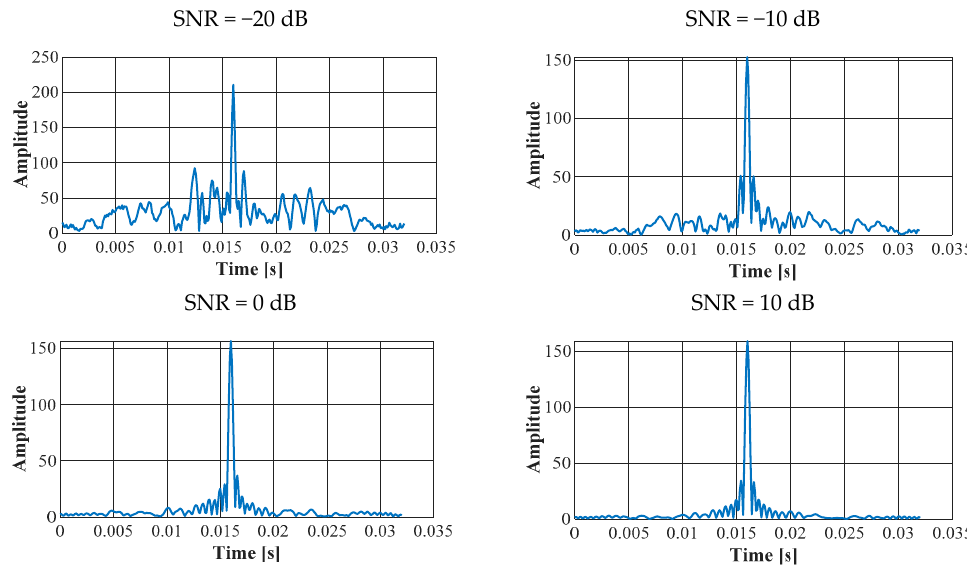
Figure 5. Correlation functions for the HFM-UP signal ( T PS = 16 ms).